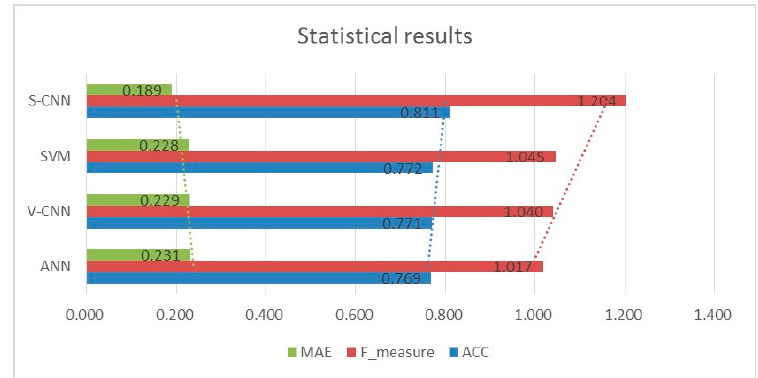
Figure 17. The mathematical statistics of the four models.